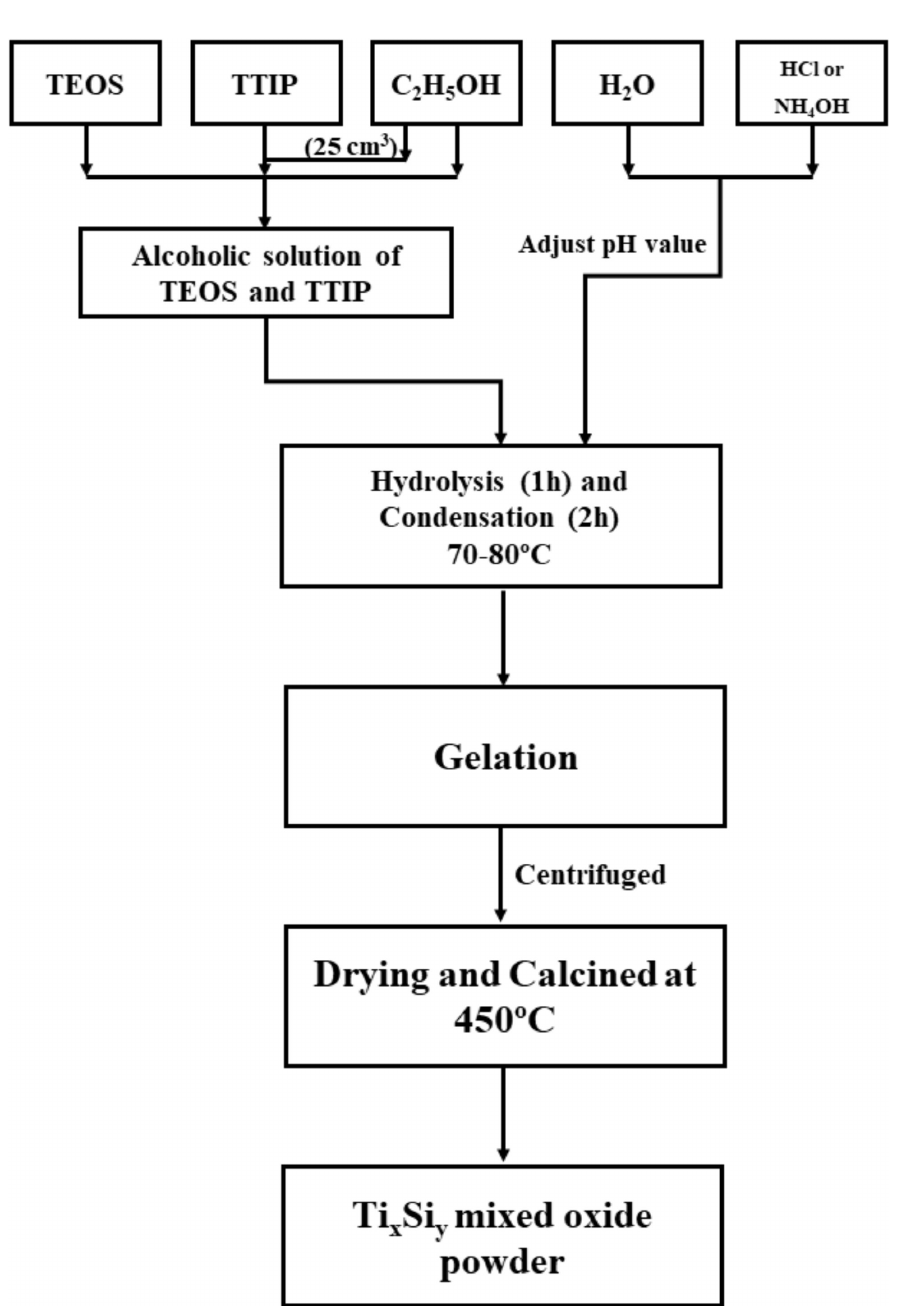
Figure 1. Experimental procedures for preparing Ti x Si y oxide